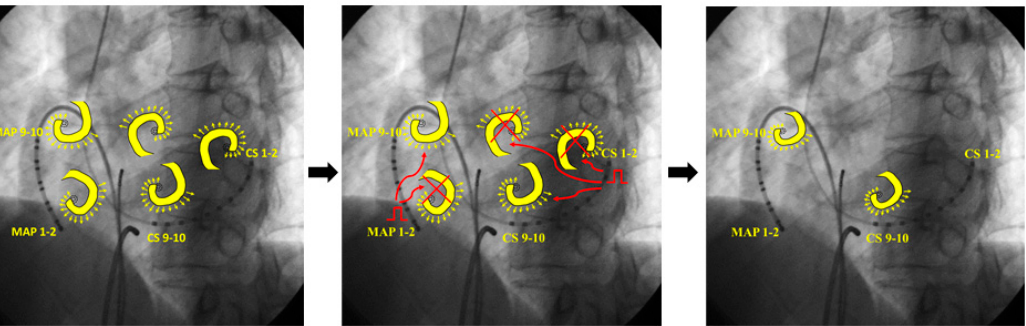
Figure 9. Three possible hypotheses for the mechanisms of AF termination. Leading circle theory; The presence of an excitable gap is well known for maintenance of AF. Pacing stimuli entrain and fill the excitable gaps of tachycardia, affecting the refractory period. Eventually, AF is unable to sustain itself and thus terminates slowly. CS = coronary sinus.